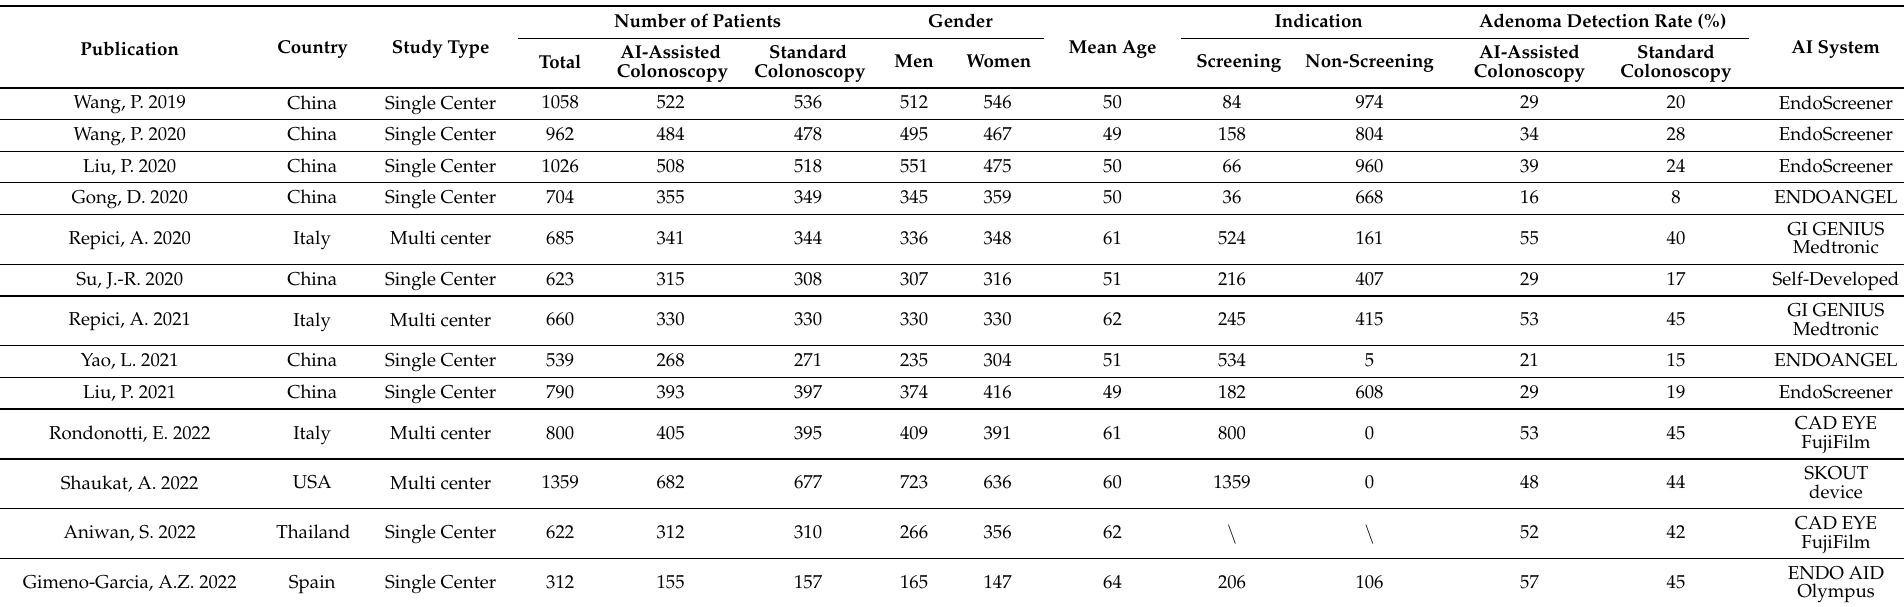
Table 1. Parallel Randomized Controlled Trials.